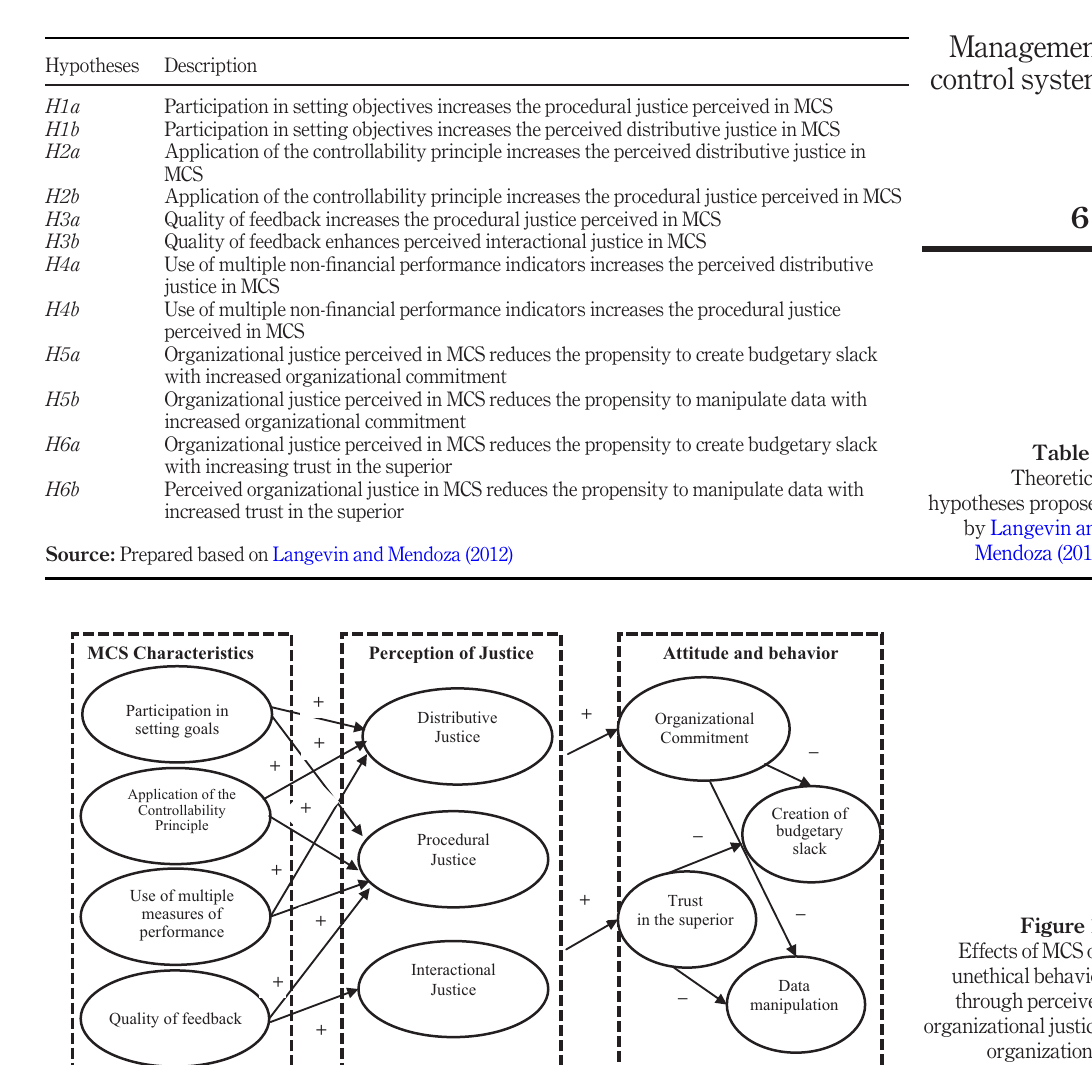
Figure 1. Effects of MCS